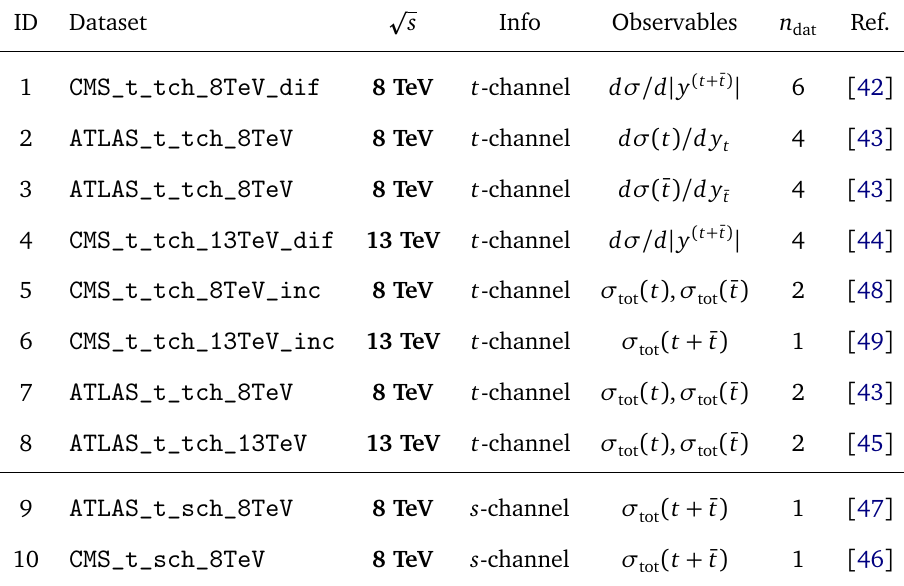
(cid:112) s , the produc- , and the publication dat